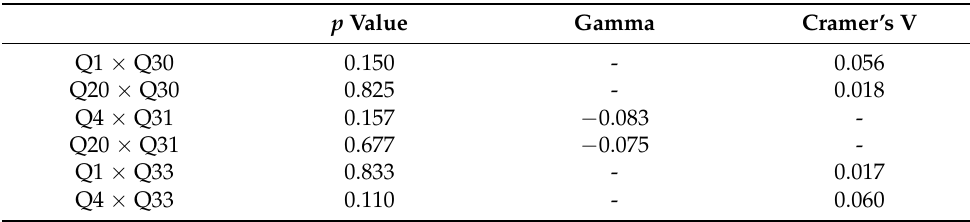
Table A6. Summary of the measures of the chi-square χ 2 test for the cross tables presented in Tables A3–A5.